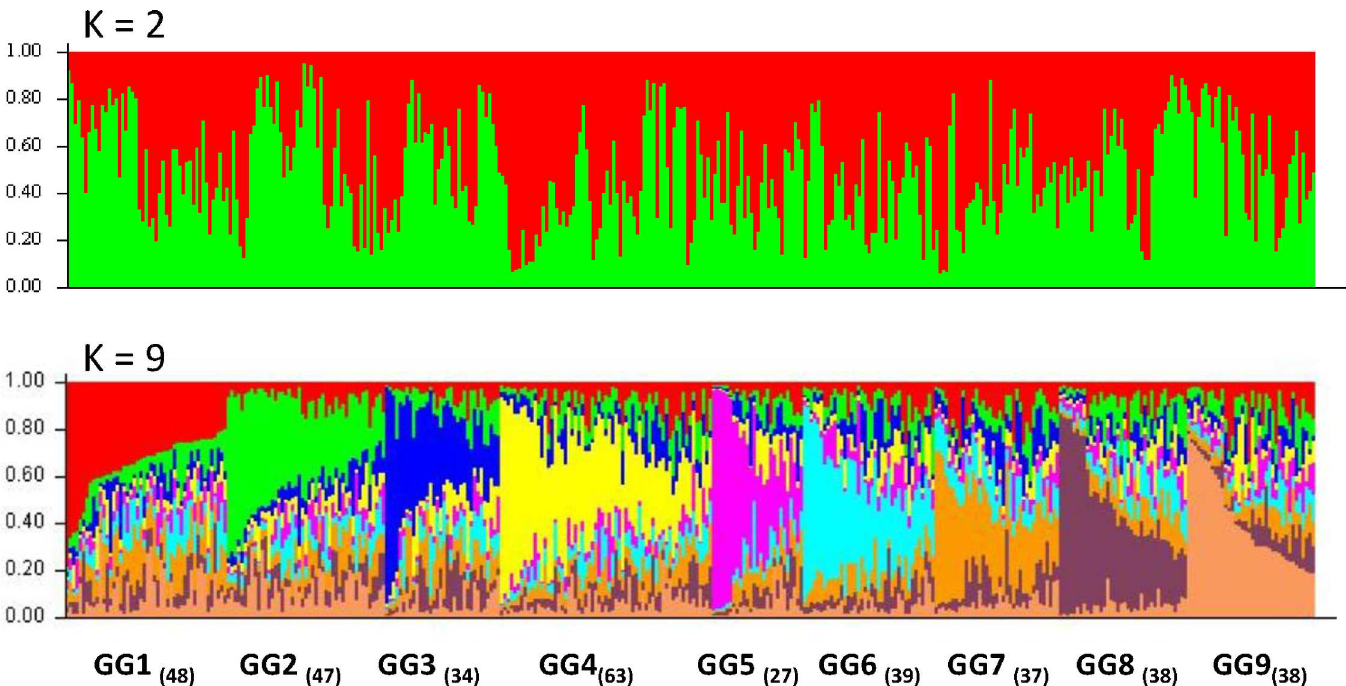
Fig 7. Population structure as shown by bar plot of the estimated membershipcoefficient (Q) of genotyped samples with SNPs matrix. All genotyped samples were clusteredinto nine subpopulations (geneticsubgroupsGG-1 to GG-9). Numbers of individualsassignedto each geneticgroup are shown in round brackets. Each vertical bar representsone sample, and a subpopulation (genetic subgroup)is shownin one main color. In the vertical bar, the length of each K coloredsegment corresponds to the proportionof allelescontributedby each of the K